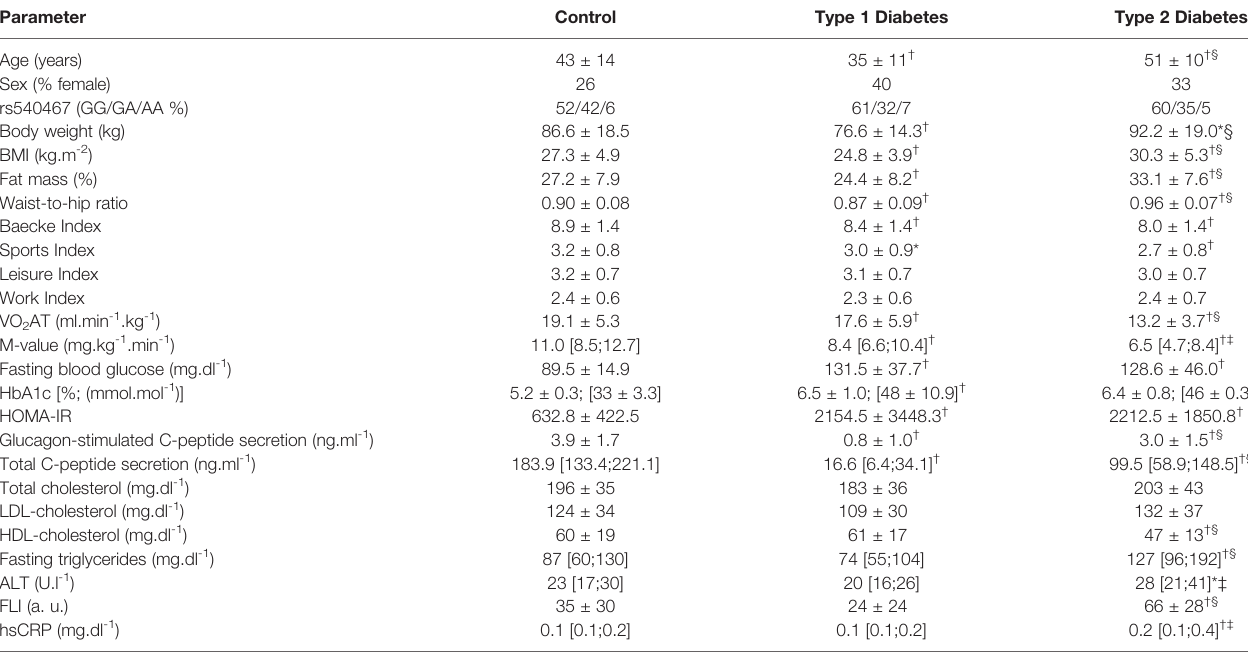
TABLE 1 | Baseline characteristics of healthy controls (n=84), patients with type 1 (n=212) and type 2 (n=215) diabetes.